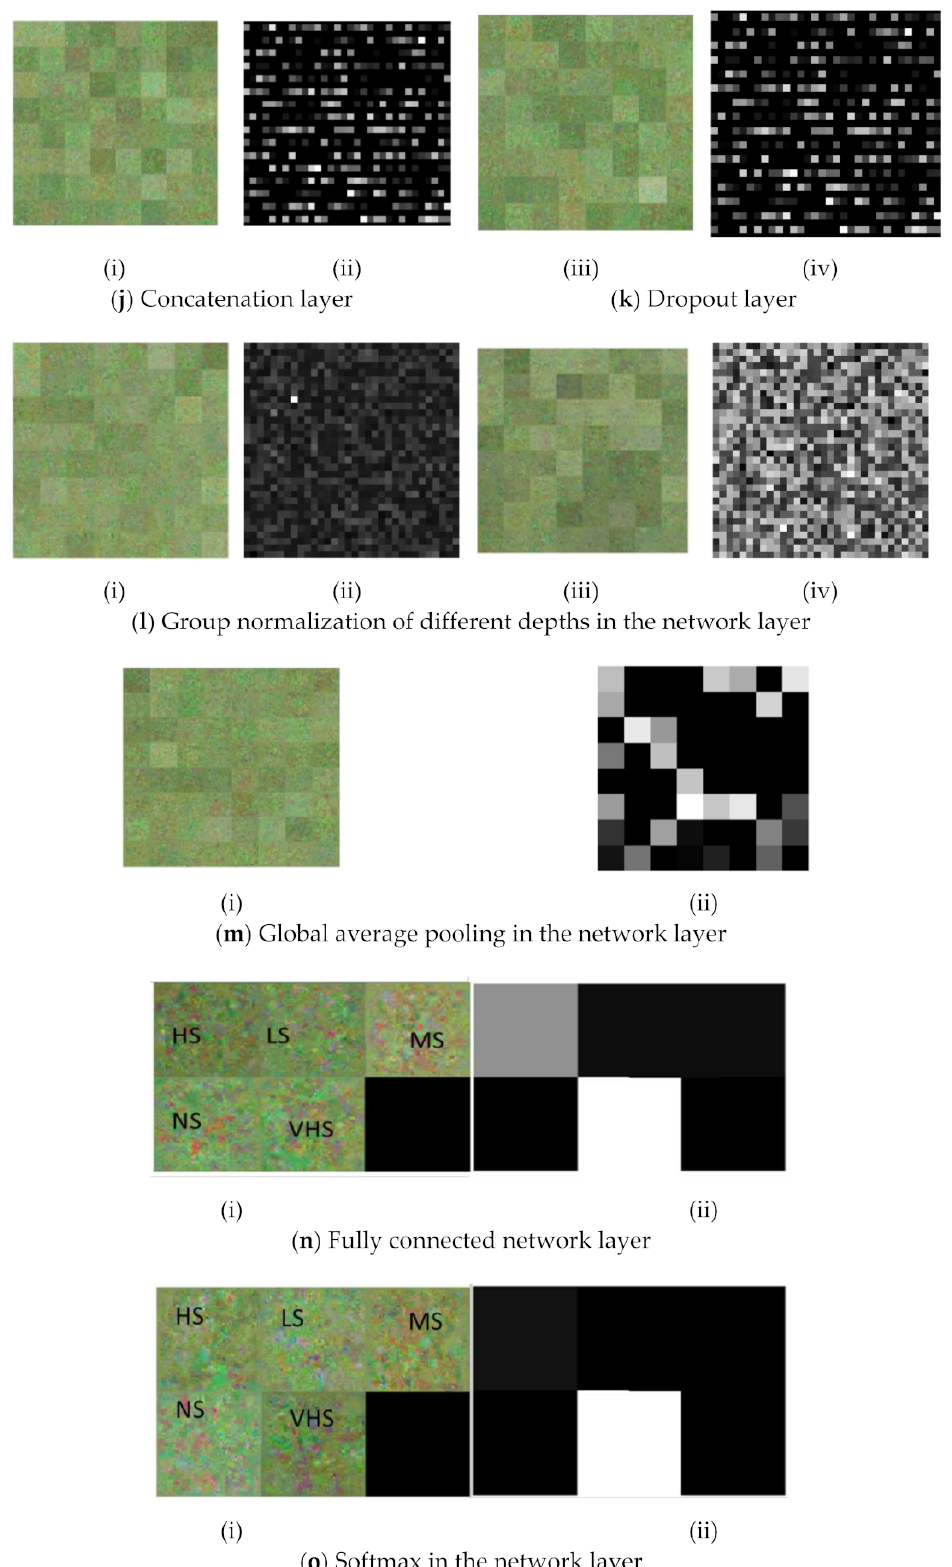
Figure 10. Visualization of network features and layer activations at different depths of the